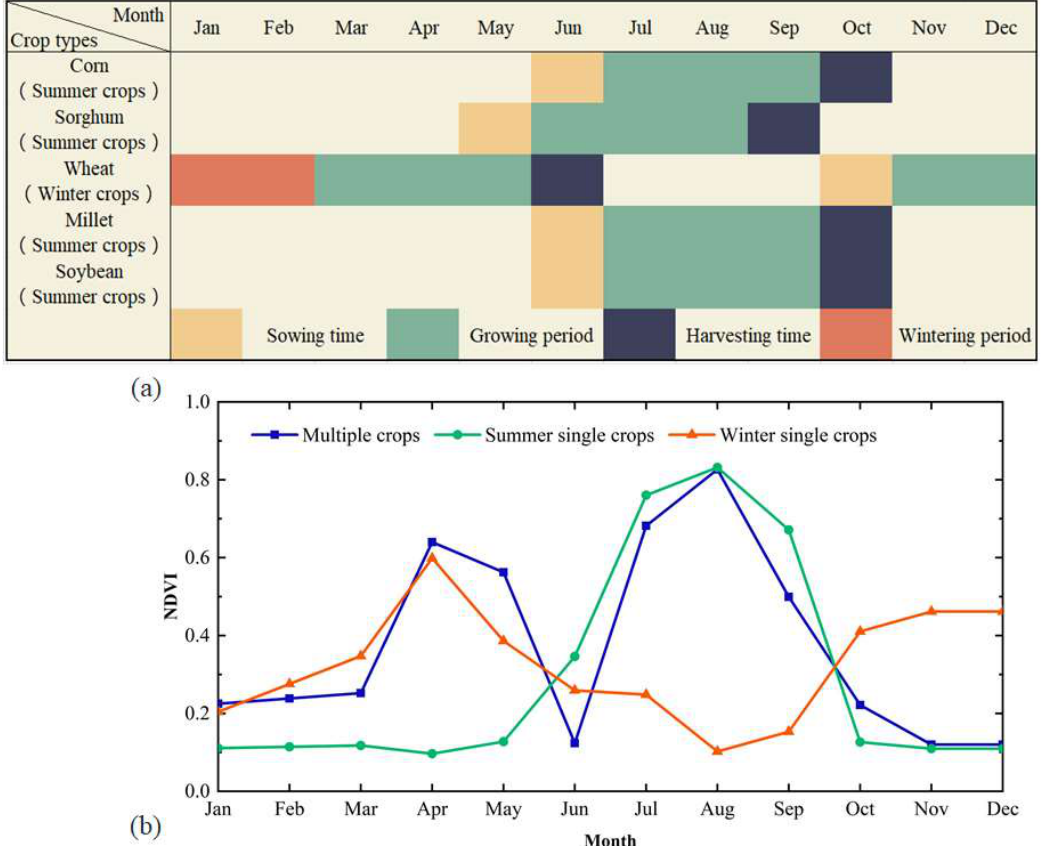
Figure 8. ( a ) Local main crops and their phenology. It consists of the real data collected from these fields. ( b ) are the corresponding time series Normalized Difference Vegetation Index (NDVI) curves of each crop samples. There are three types of crops in the study area: multiple crops, winter single crops, and summer single crops. The samples from various locations were collected by field investigation.